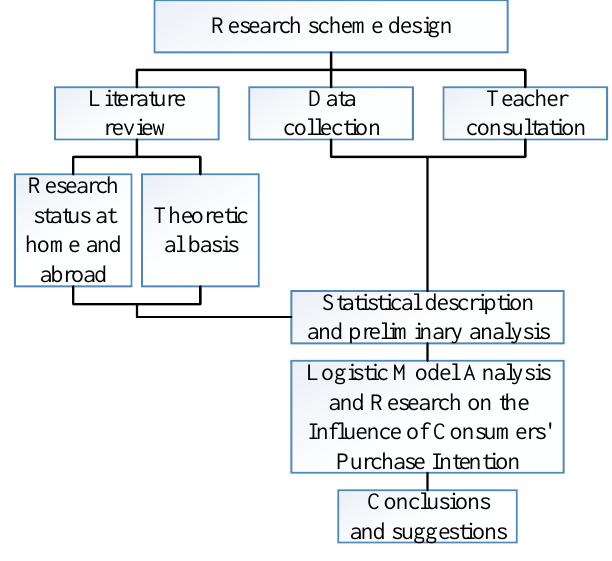
Figure 9. Technical Roadmap.